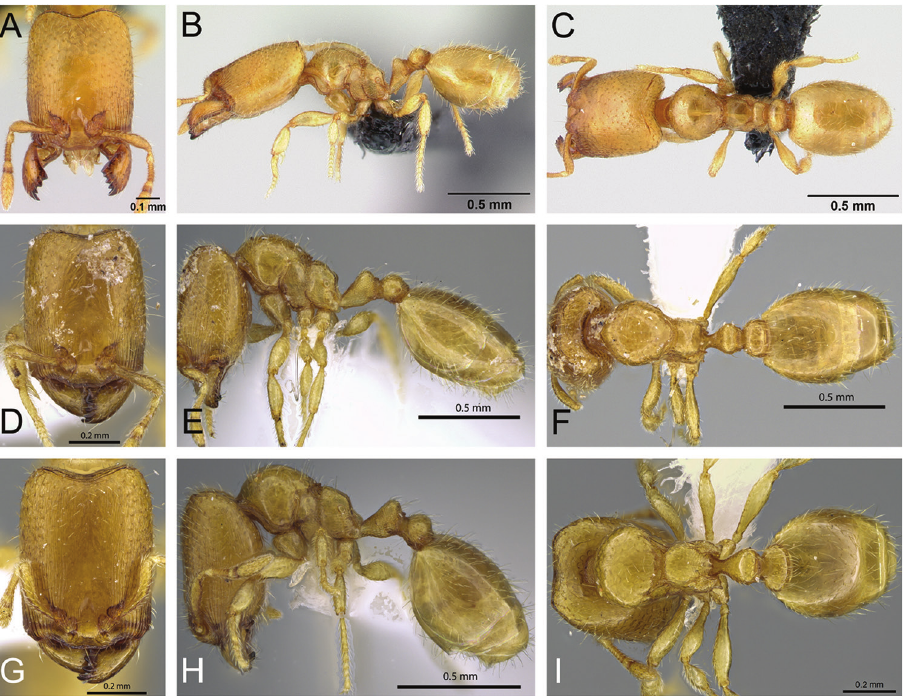
Figure 32. Intermediates of Carebara bara . Major workers, CASENT0482934. A head in full-face view B body in profile view C body in dorsal view. CASENT0127693 D head in full-face view E body in profile view F body in dorsal view. CASENT0439907 G head in full-face view H body in profile view I body in dorsal